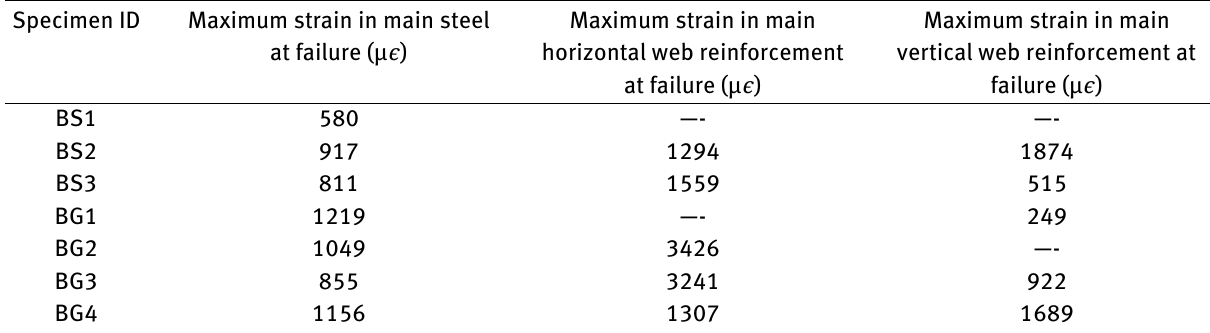
Table 6: Strain of deep beams